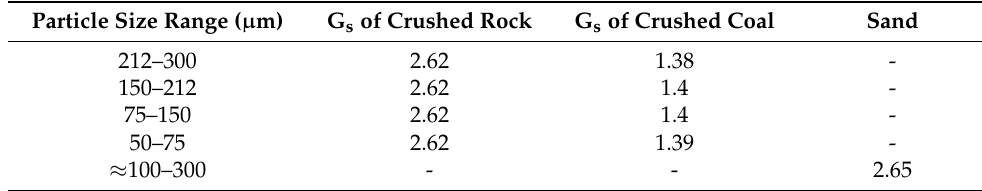
Table 1. Specific gravity (G s ) of the natural sand and the crushed rock and crushed coal at each size fraction.